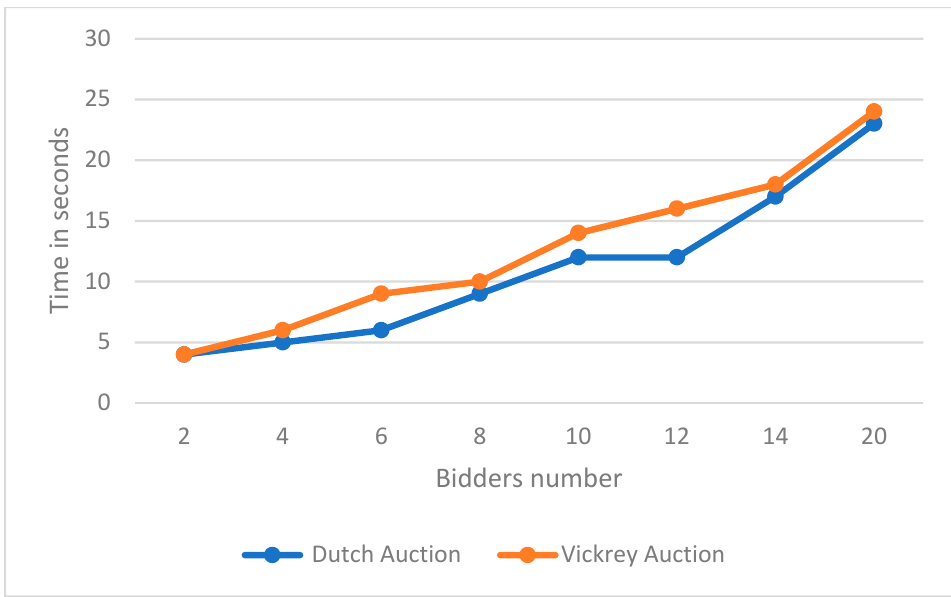
Figure 8. Messages required to complete an auction as the number of bidders grows in a supply- driven scenario.